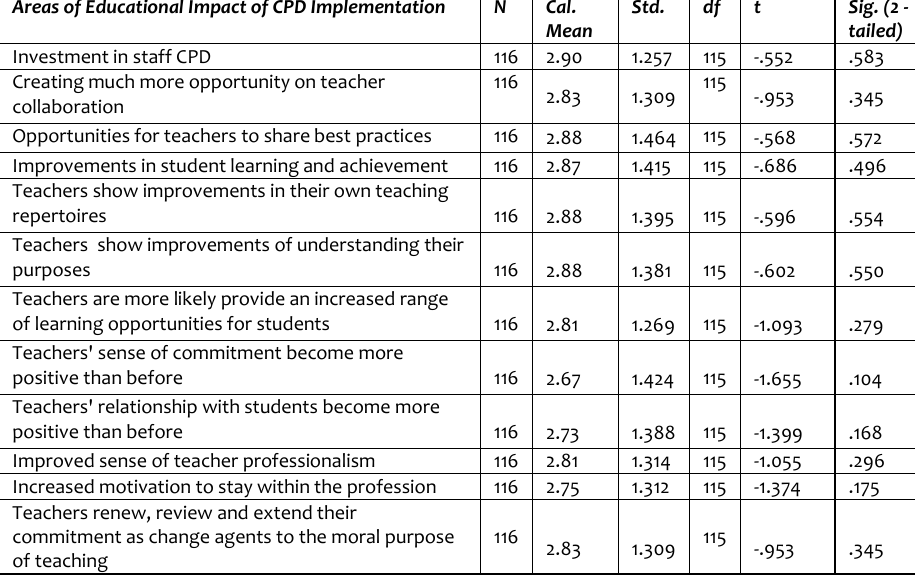
Table 2: Impact of Teachers’ CPD Implementation to Quality Education, test value=3 Areas of Educational Impact of CPD